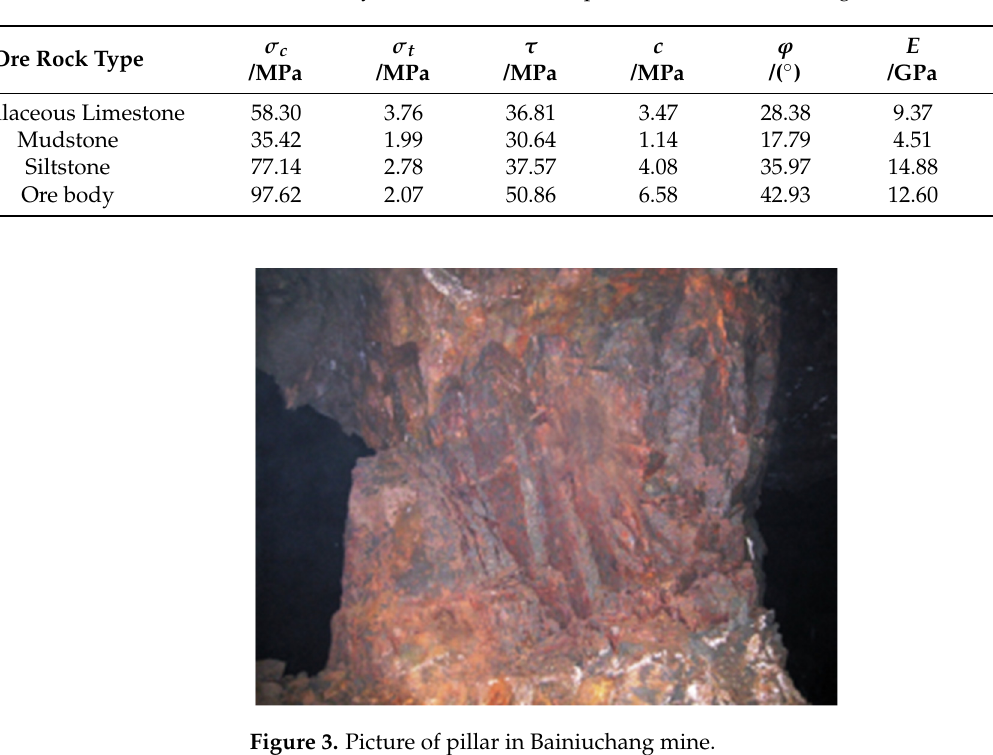
Figure 5. Finite element calculation model. Mesh refinement analysis: If the mesh is sparse, the accuracy of calculation cannot meet the requirements. The finer the mesh, the higher the accuracy of calculation, but the amount of calculation will increase exponentially. In order to balance the calculation ac- curacy and efficiency, considering the regularity of the element, we established a material model based on the key points by using ANSYS. This work is according to the geological structure model and the distribution changes of the physical property parameters of each layer in the mining area. Using the tetrahedron (SOLID92) 10 node element type, we di- vided the finite element mesh of each volume element. The whole mesh was divided into 57,611 elements and 79,159 nodes (Figure 6). Figure 6. Finite element model meshing. Initial stress conditions: Calculated the distribution of in situ stress according to grav- ity, as shown in Figure 7.